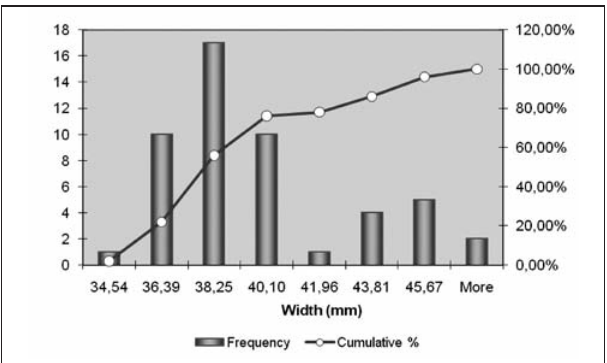
Fig. 31: Distribution of width values of category B of Bergeron apricot